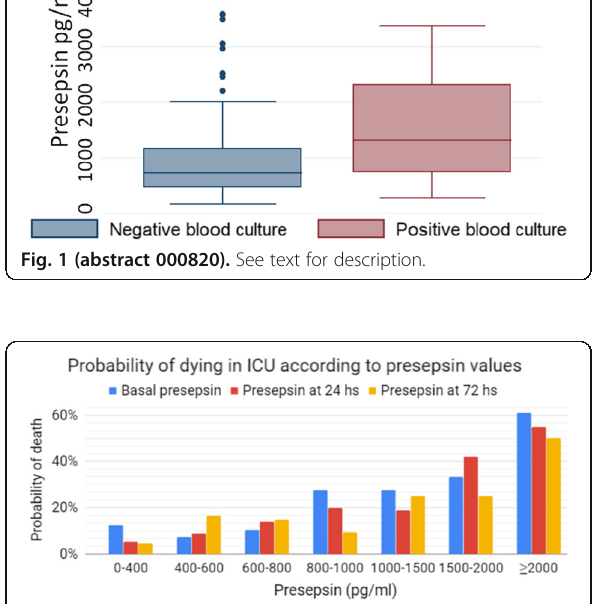
Fig. 2 (abstract 000820). See text for